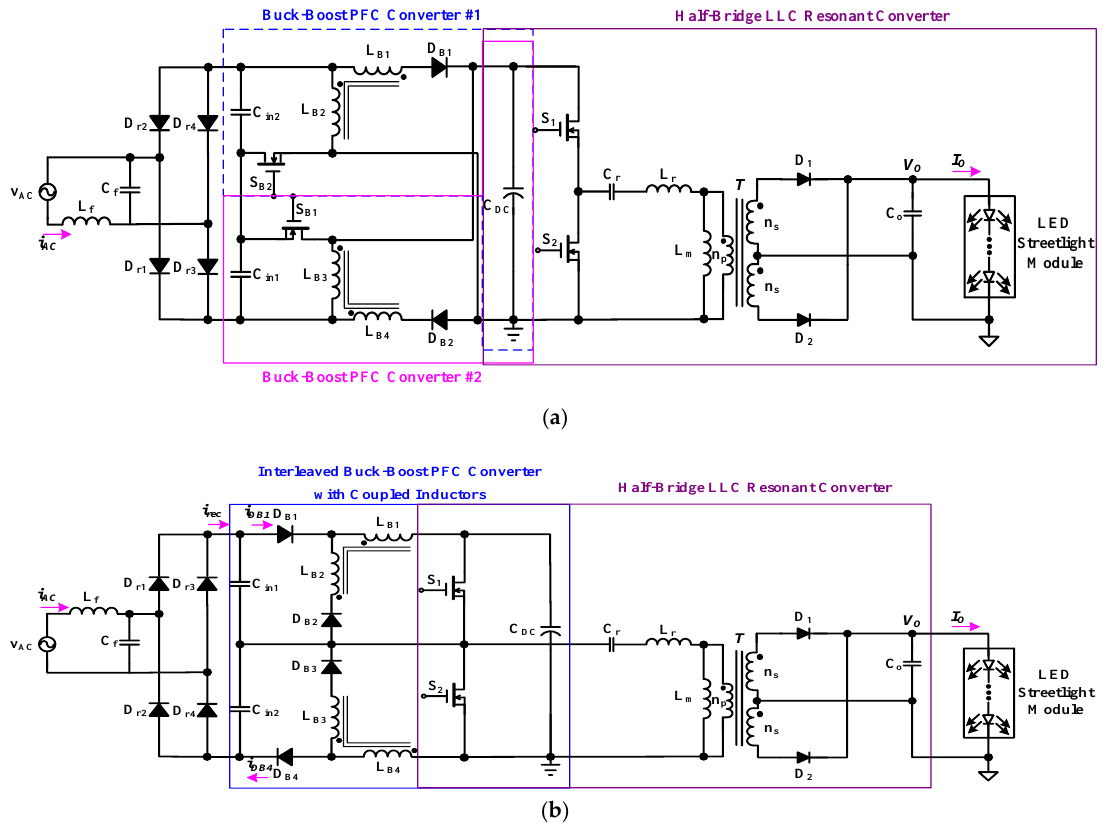
Figure 2. ( a ) Original two-stage LED streetlight driver; ( b ) the presented single-stage LED streetlight driver with coupled inductors and interleaved PFC feature.